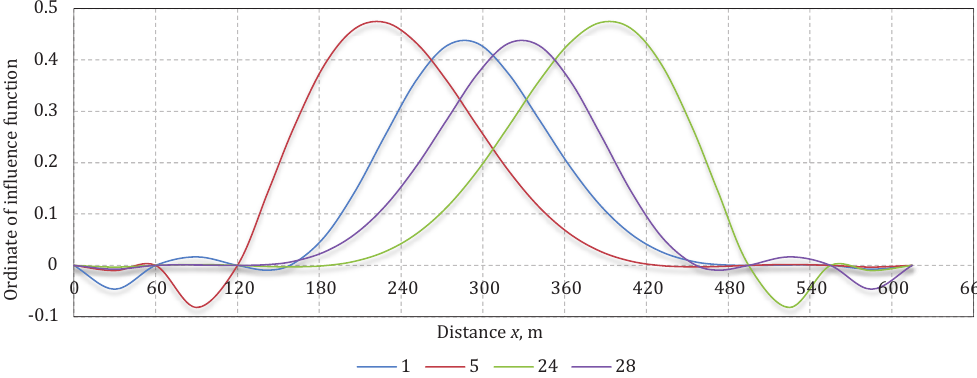
Figure 4. Diagrams of the influence functions of the axial forces in the cables used in analysis, i.e., Nos. 1, 5, 24,